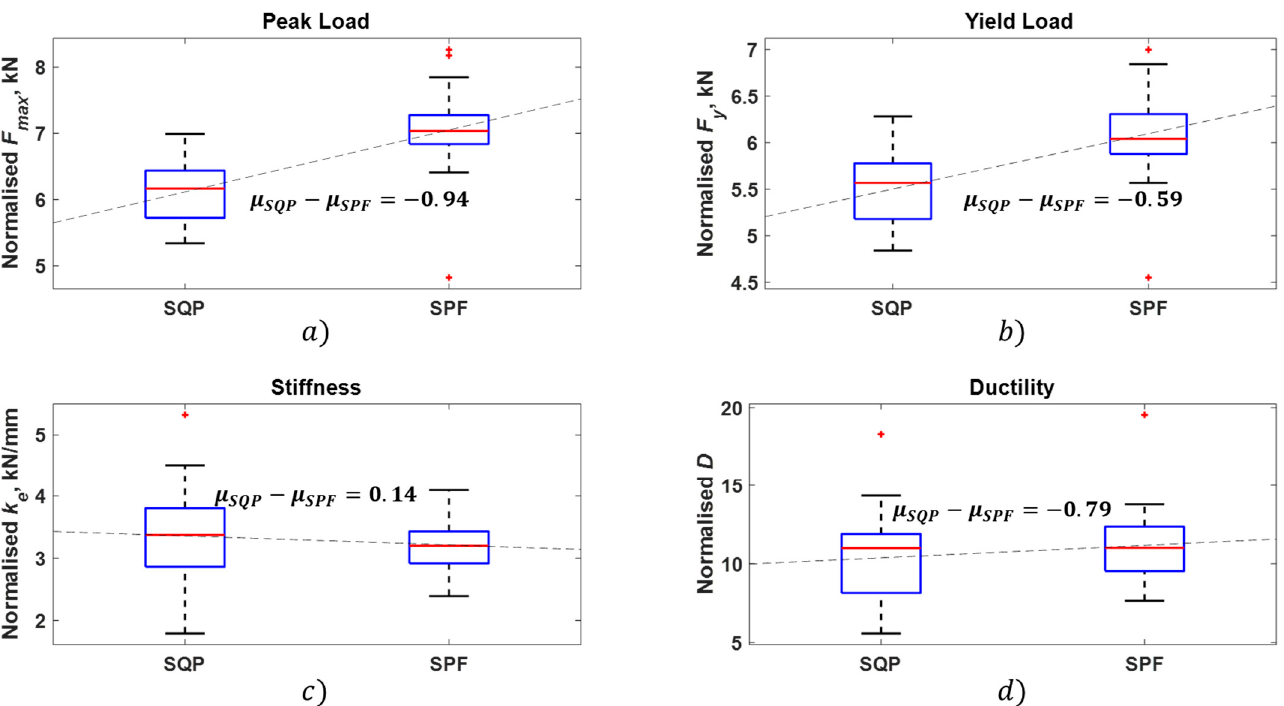
Figure 12. Boxplot comparisons of Southern Queensland pine (SQP) and spruce/pine/fir (SPF) STC specimens by normalised ( a ) peak load, ( b ) yield load, ( c ) stiffness, and ( d ) ductility.